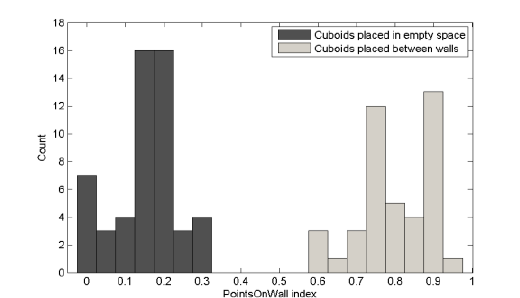
Figure 7. Distribution of point-on-wall indices for cuboids placed in empty spaces and on the walls.